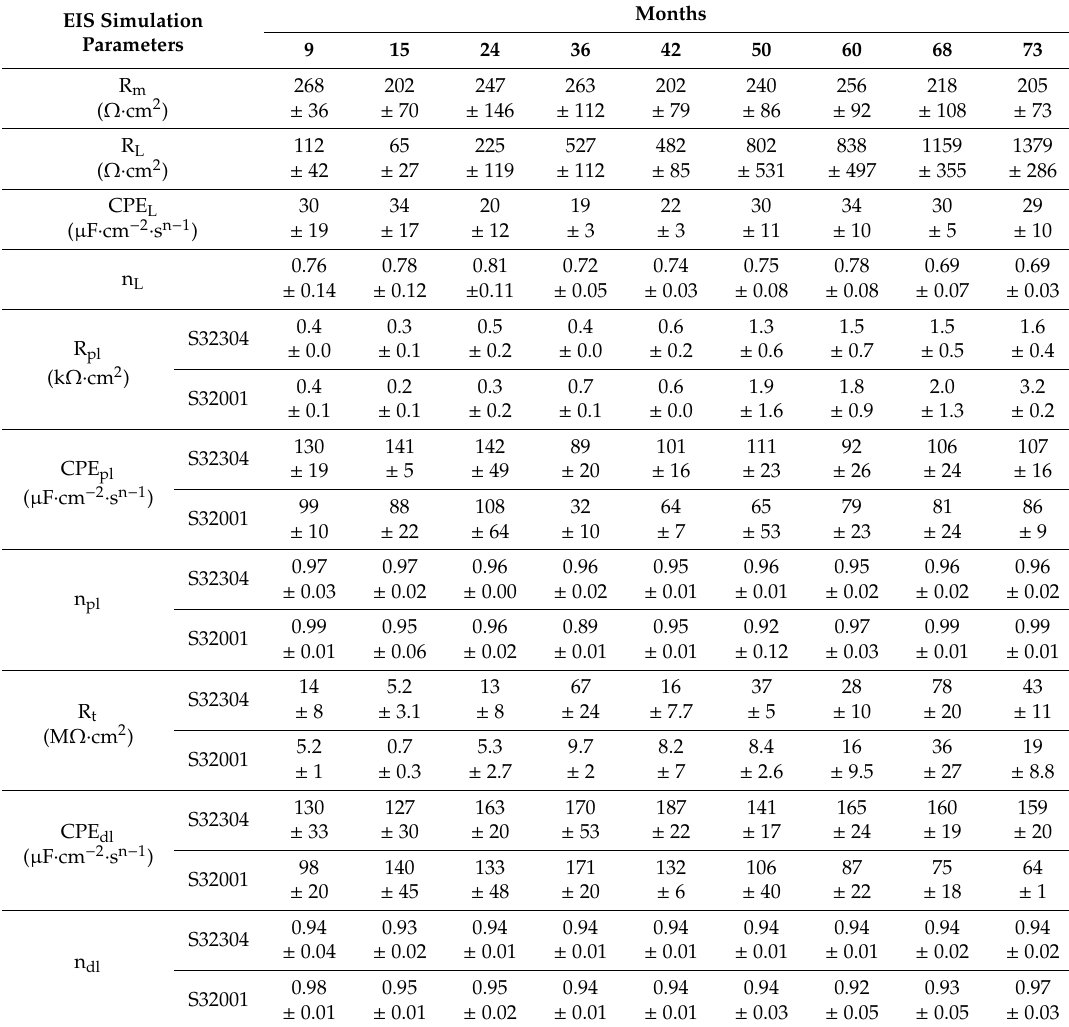
Table 3. Results from simulations of the EIS spectra of reinforced samples tested under PI